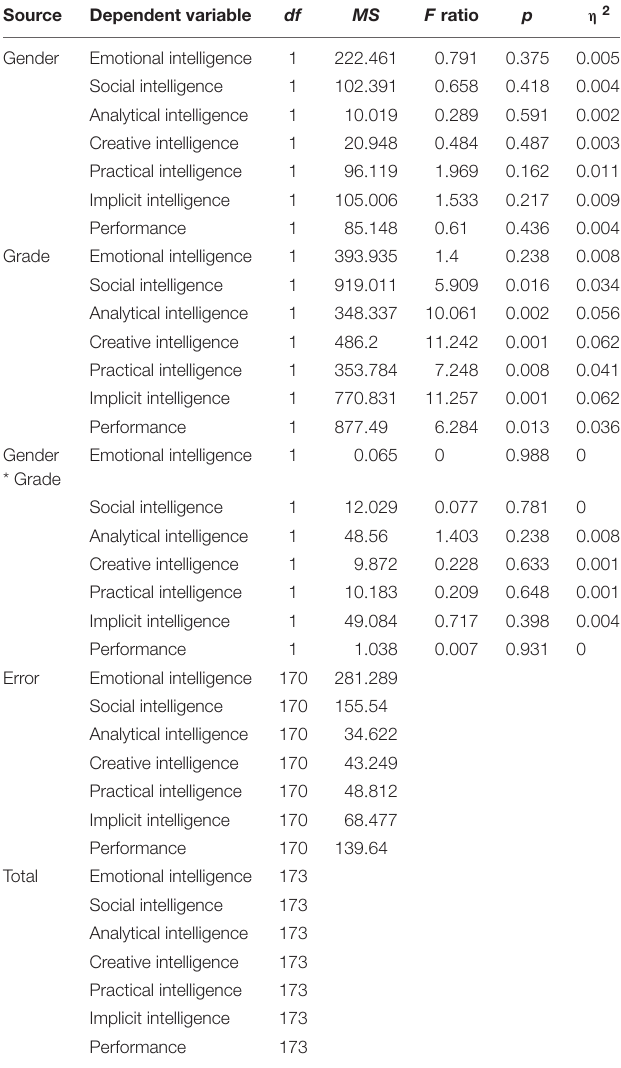
TABLE 2 | MANOVA of dependent variables by gender and